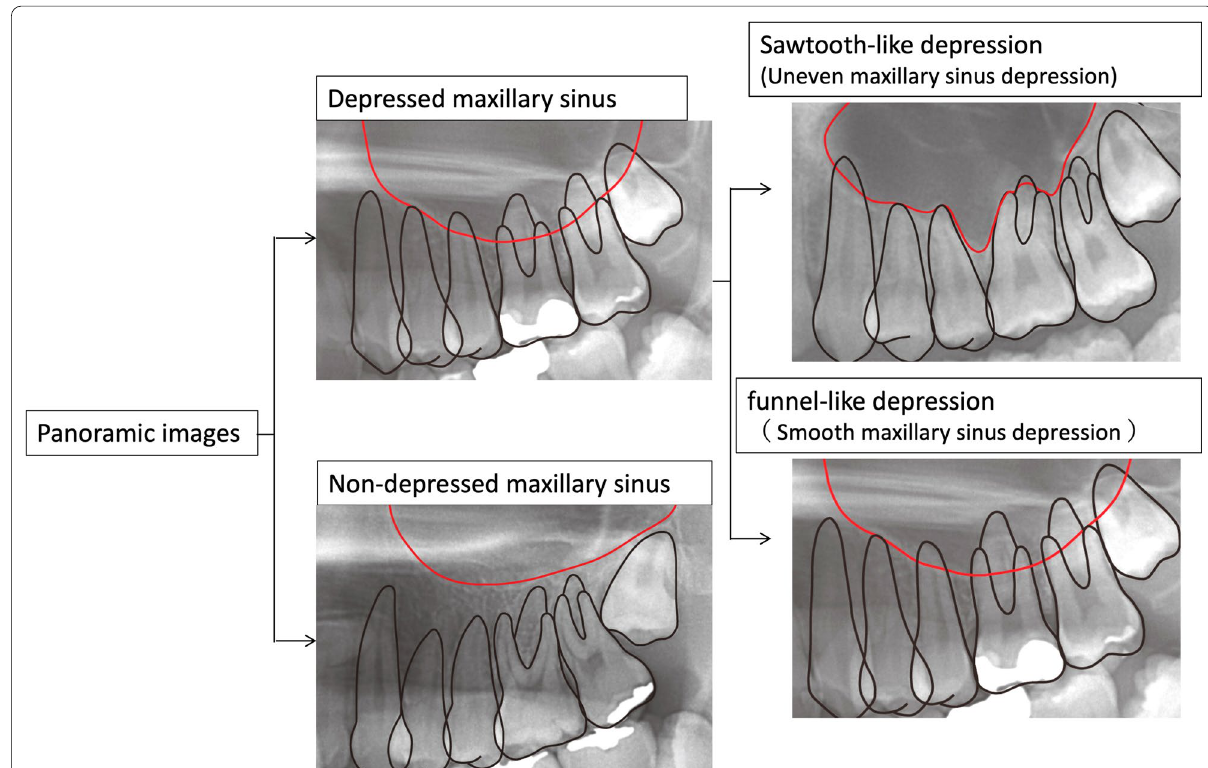
Fig. 1 Classification of maxillary sinus morphology on panoramic images. On panoramic images, the maxillary sinus morphology was classified into two types: one in which the sinus floor was depressed such that it was adjacent to the alveolar bone between the maxillary molars (depressed sinus type) and the other in which it was not depressed (non-depressed sinus type). The depressed sinus type was further classified according to the sinus floor morphology into two types: the sawtooth-like depression type and the funnel-like depression